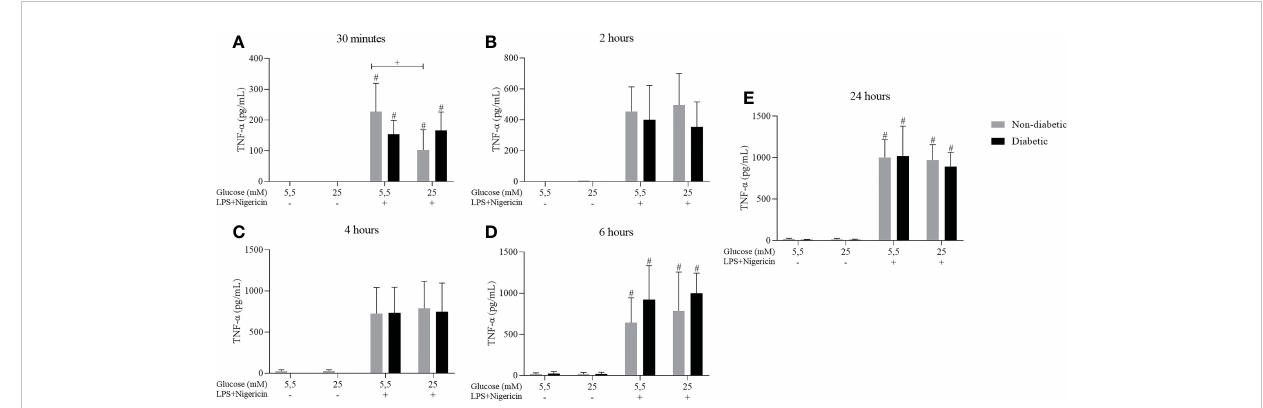
FIGURE 5 TNF- a secretion by ND-BMDM and D-BMDM with Nigericin priming and LPS stimulation. IL-6 release after (A) 30 minutes with different glucose concentrations. #P<0.05 stimulated vs non stimulated. + P<0.05 D-BMDM 25Mm+ vs ND-BMDM 25mM-. (B) 2 hours with different glucose concentrations. (C) 4 hours with different glucose concentrations. (D) 6 hours with different glucose concentrations. #P<0.05 stimulated vs non stimulated (E) 24 hours with different glucose concentrations. #P<0.05 stimulated vs non stimulated. TNF- a measurement was performed by enzyme-linked immunosorbent assay. Results represent mean ± SEM. N = 7-13. BMDM: Bone-Marrow Derived Macrophages, from diabetic (D-) and non-diabetic (ND-) C57BL/6 mice.